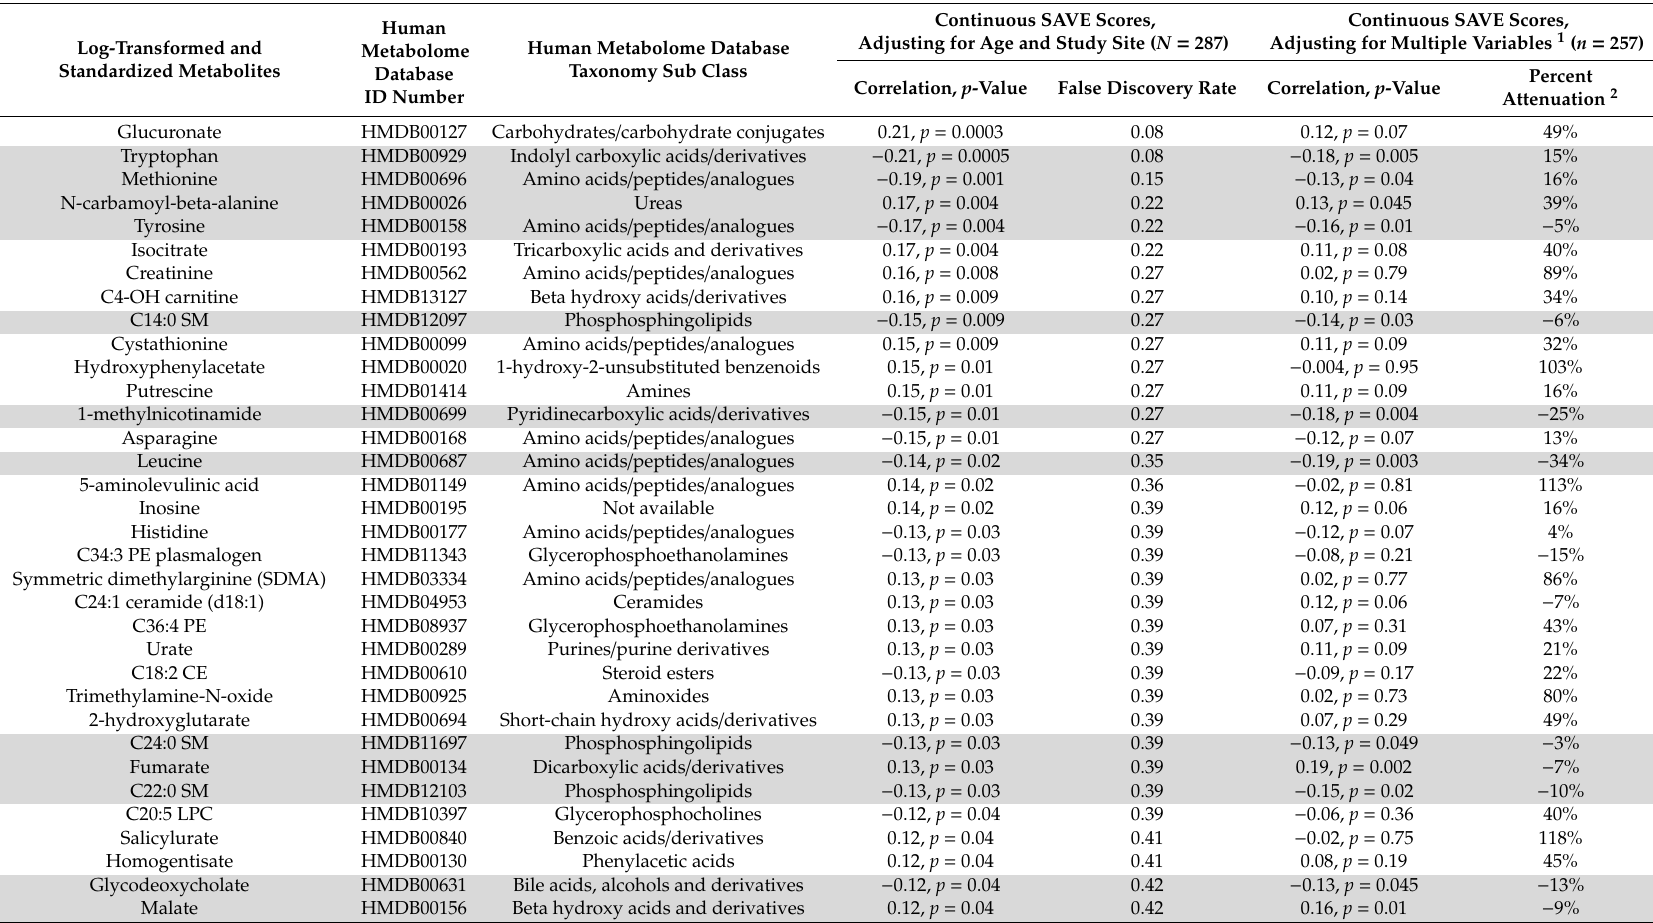
Table 2. Age and study site-adjusted correlation of 37 top metabolites with scores on the Scale of Aging Vigor in Epidemiology (SAVE) ( p < 0.05) and attenuations after further adjustments among 287 black men from the Health, Aging, and Body Composition